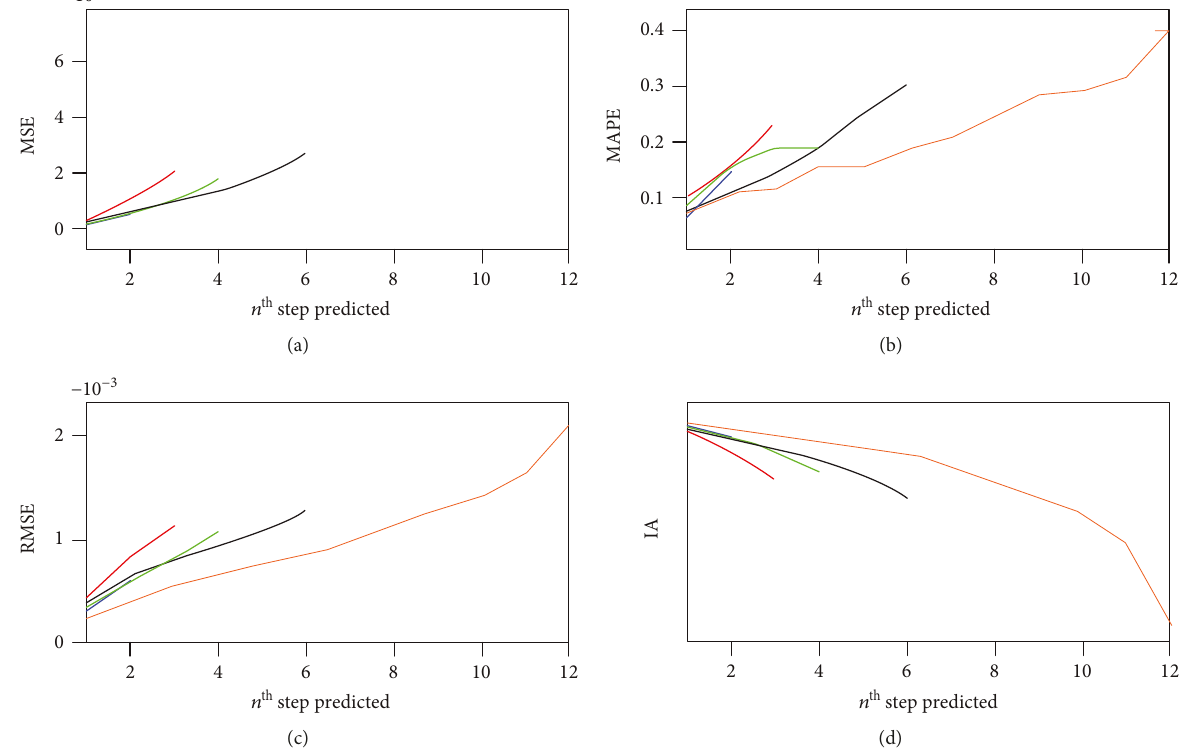
Figure 7: Lorenz system: indicators from ANN — (a) MSE, (b) MAPE, (c) RMSE, and (d) IA.